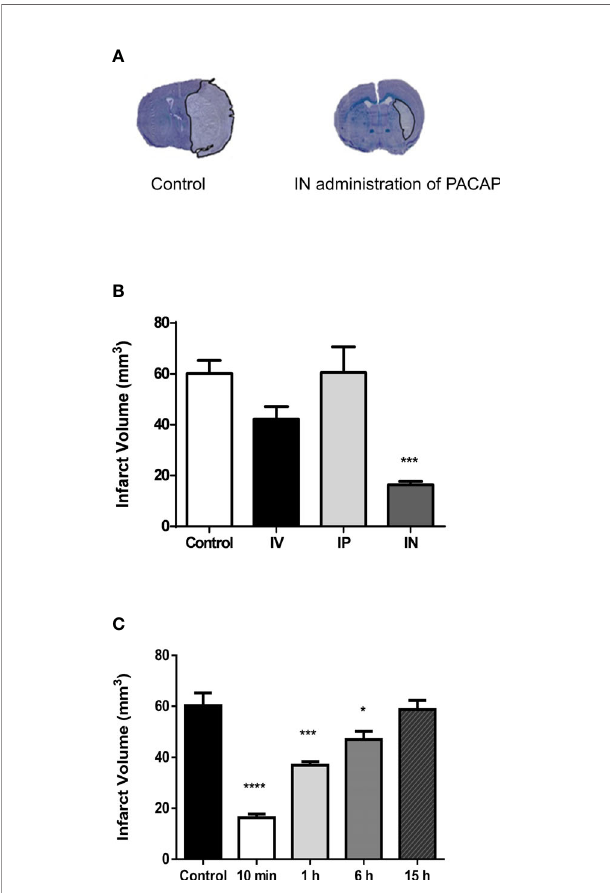
FIGURE 1 | Effect on cerebral infarct volume of PACAP administration 2 days after tMCAO. (A) Illustration of the brain infarct area after NaCl (Control) or PACAP (IN administration of PACAP) intranasal administration, 48 h after tMCAO. (B) Quanti fi cation of the brain infarct volume of mice treated 10 min after the reperfusion by intranasal administration of NaCl (0.9%; Ctrl; n = 7), intravenous administration of PACAP (200 m l at a concentration of 0.02 m g/kg with 100 m l in the form of a bolus and then 100 m l by infusion over a 30-min period; IV; n = 7), intraperiotoneal administration of PACAP (200 m l in the form of a bolus at a concentration of 0.02 m g/kg; IP; n = 8) or intranasal administration of PACAP (10 µg in 10 µl; IN; n = 7), 48 h after a 45-min tMCAO. (C) Quanti fi cation of the brain infarct volume of mice treated 10 min (n = 8), 1 h (n = 8), 6 h (n = 8) or 15 h (n = 7) after reperfusion by an intranasal administration of PACAP (10 µg in 10 µl; IN). Control animals (Ctrl; n = 7) received 10 µl NaCl 0.9% IN administration. Volume was expressed in mm 3 . ANOVA followed by the Bonferroni ’ s test. * P < 0.05; *** P < 0.001; **** P < 0.0001 vs.